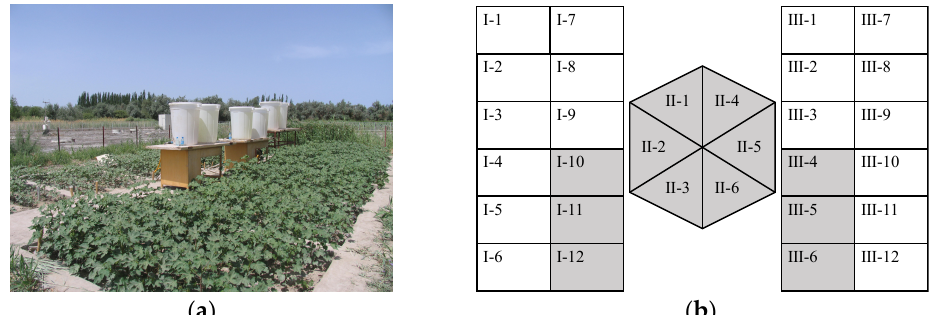
Figure 2. ( a ) Lysimeters where the experiment was carried out; ( b ) schematic diagram of the experimental site (the gray in this figure indicates the lysimeters that were not used). Note: I-1 represents the first experimental field in Field One and so on.